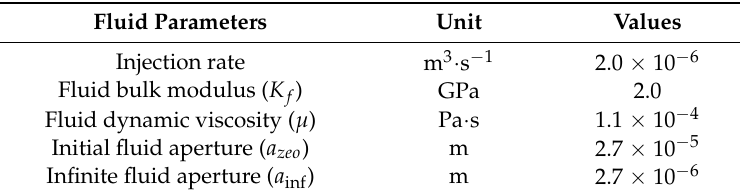
Table 3. Computational parameters of fluid